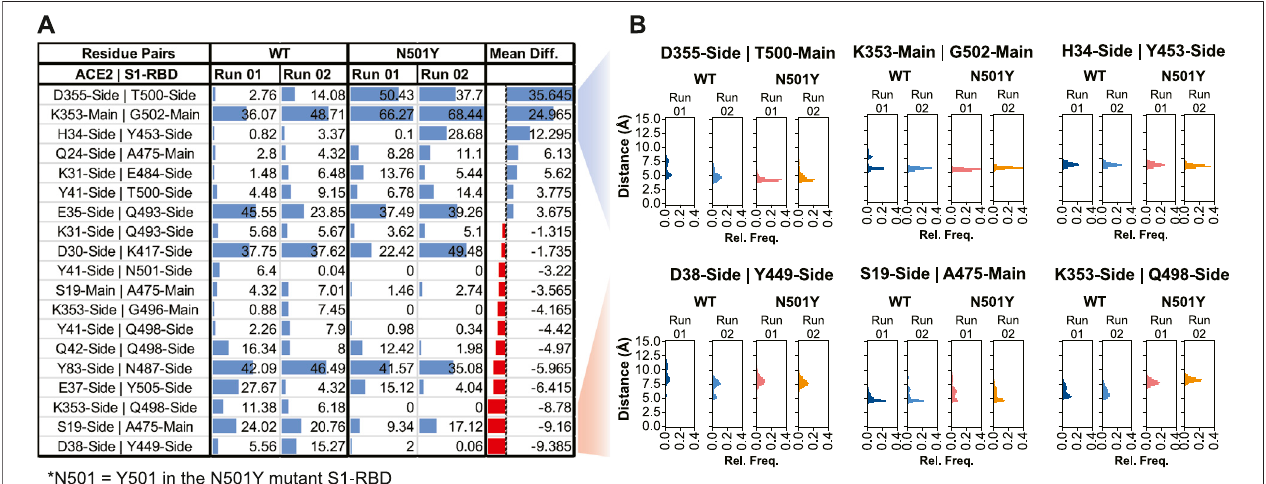
FIGURE 4 | Altered H-bonding between ACE2-S1-RBD interfacial residues. (A) Table showing H-bonds formed at the interface by applying a cut-off of 3.5 Å distance, 20 ° angle, and ≥ 5% occupancy time. Numbers represent the % occupancy time of the H-bond during the total simulation time. (B) Histograms representing distance measurements between H-bond forming pairs that showed the highest alterations in H-bond formation at the interface. Mean Diff, Mean difference, i.e.,differencebetweenH-bondmeanpercentoccupancytimeoftheWTandmutantcomplexes.Blueandredcolorsindicateincreaseanddecreaseinoccupancy time, respectively, in the mutant